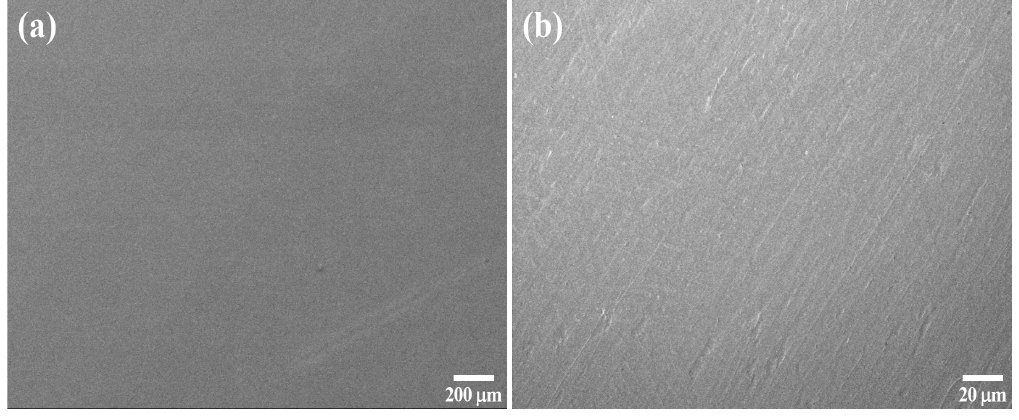
Figure 5. SEM images of Ti6Al4V alloy sintered by capsule hot isostatic pressing (HIP) at ( a ) low and ( b ) high magnification.